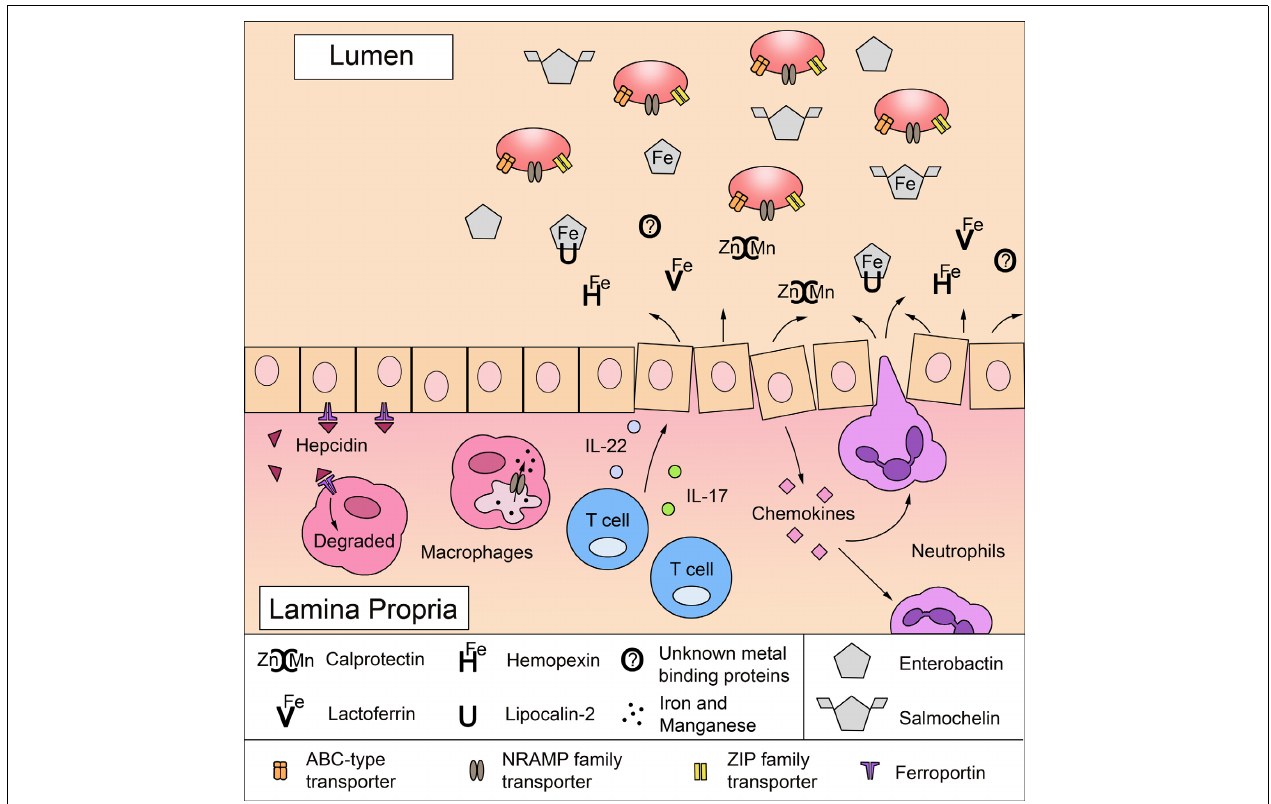
FIGURE 1 | A battle for metals in the intestinal mucosa: mechanisms of host metal sequestration and microbial metal acquisition. To limit microbial growth, the mammalian host sequesters free iron, zinc, and manganese ions by expressing proteins in the mucosa that directly bind metals or metal-binding agents in a process termed nutritional immunity. Lactoferrin binds to iron (Fe) and calprotectin binds to zinc (Zn) and manganese (Mn). Hemopexin can limit the amount of circulating iron-bound heme (He) and lipocalin-2 sequesters the bacterial iron-scavenging siderophore enterobactin. Upon infection, inflammatory mediators increase the expression of metal-sequestering proteins, which is detrimental to microbes lacking mechanisms to survive metal deprivation. Inflammatory cytokines, IL-17 and IL-22, produced by T cells induce epithelial cells to express antimicrobial proteins including lipocalin-2 and calprotectin. Furthermore, activated epithelial cells secrete CXC chemokines that recruit neutrophils to the site of infection; neutrophils also express high levels of